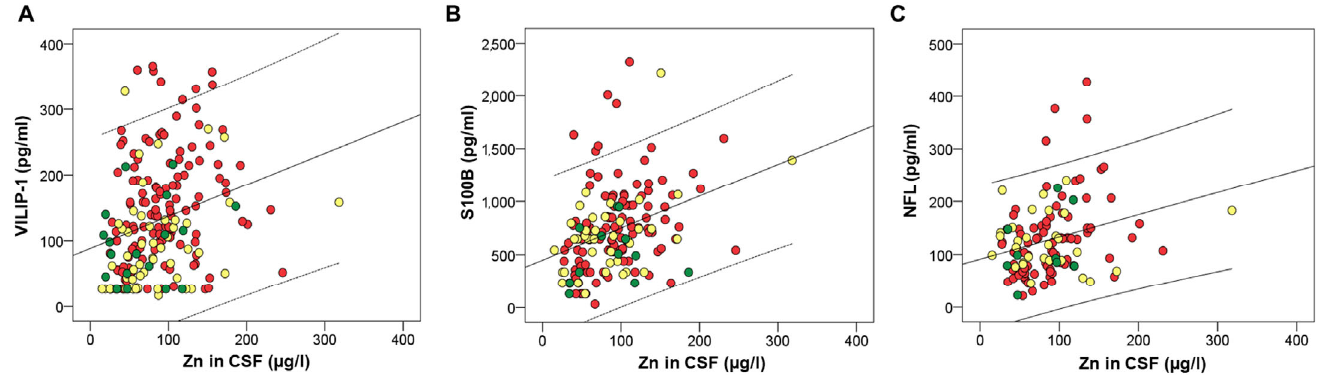
Figure 2. Correlation of CSF biomarkers VILIP-1 ( A ), S100B ( B ), and NFL ( C ) of AD with Zn measured in CSF. Red circles represent AD patients, yellow circles represent MCI patients, while green circles represent healthy